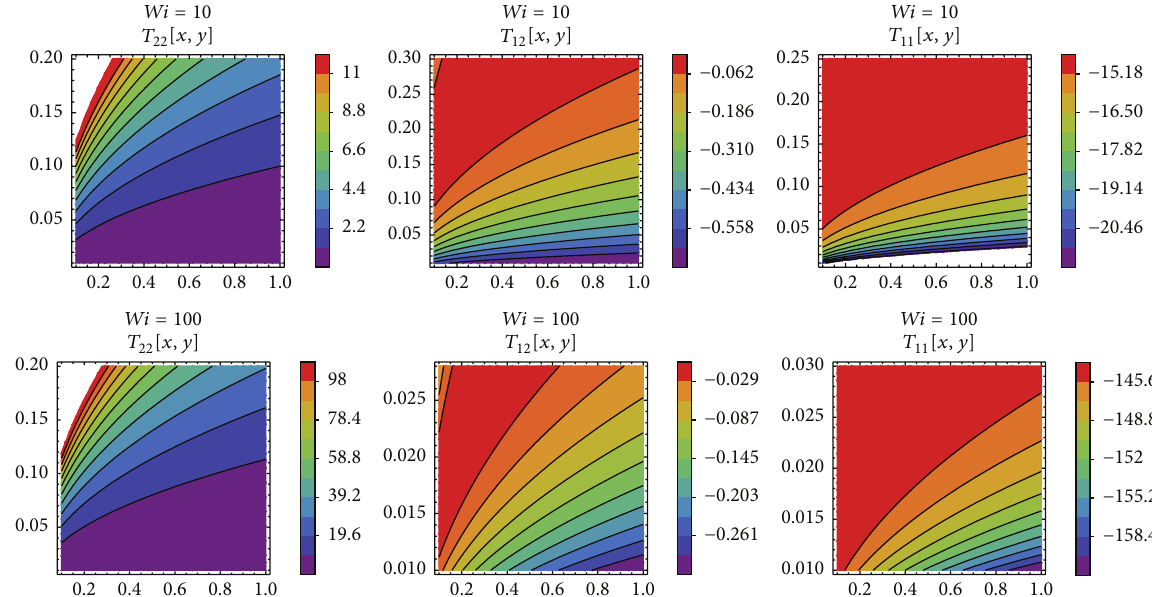
Figure 5: Dimensionless stress components on a stretching plate in the 𝑥 - 𝑦 plane: for 𝐶 = 0 for 𝑊𝑖 = 10 and 100.